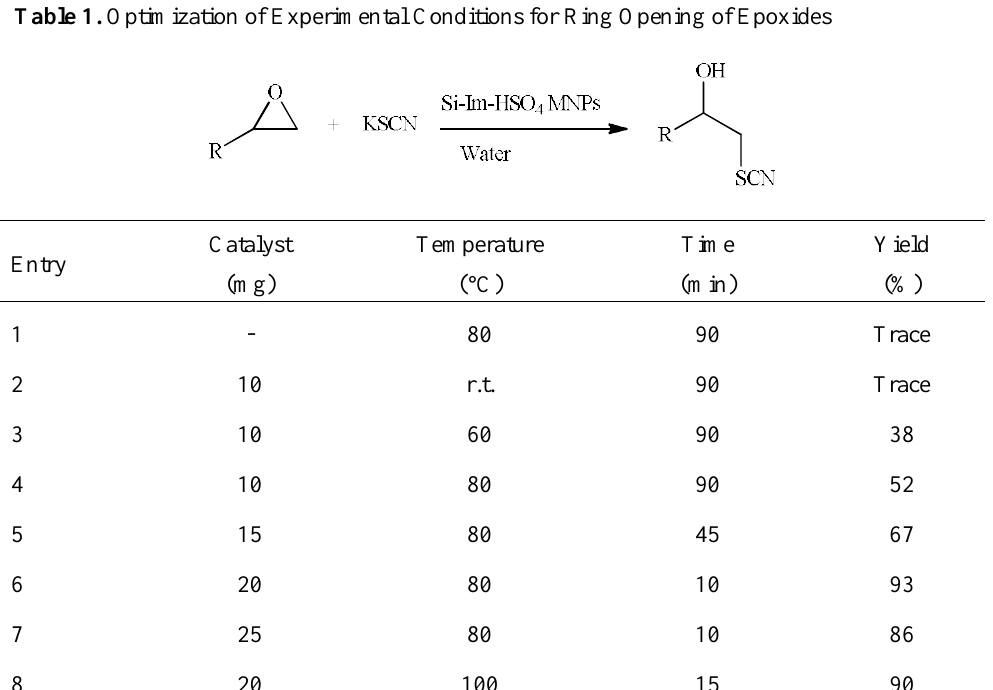
Table 1. Optimization of Experimental Conditions for Ring Opening of